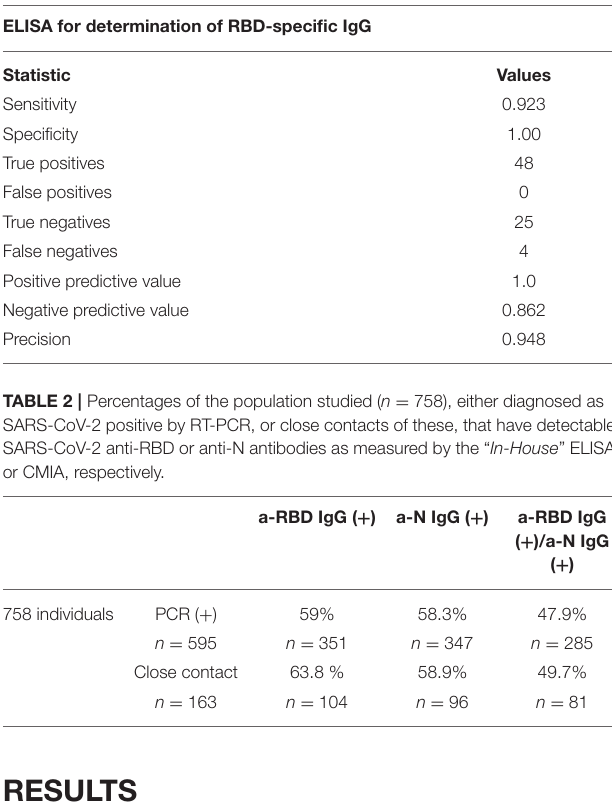
TABLE 1 | Statistic parameters of the “ In-House ” ELISA test developed.